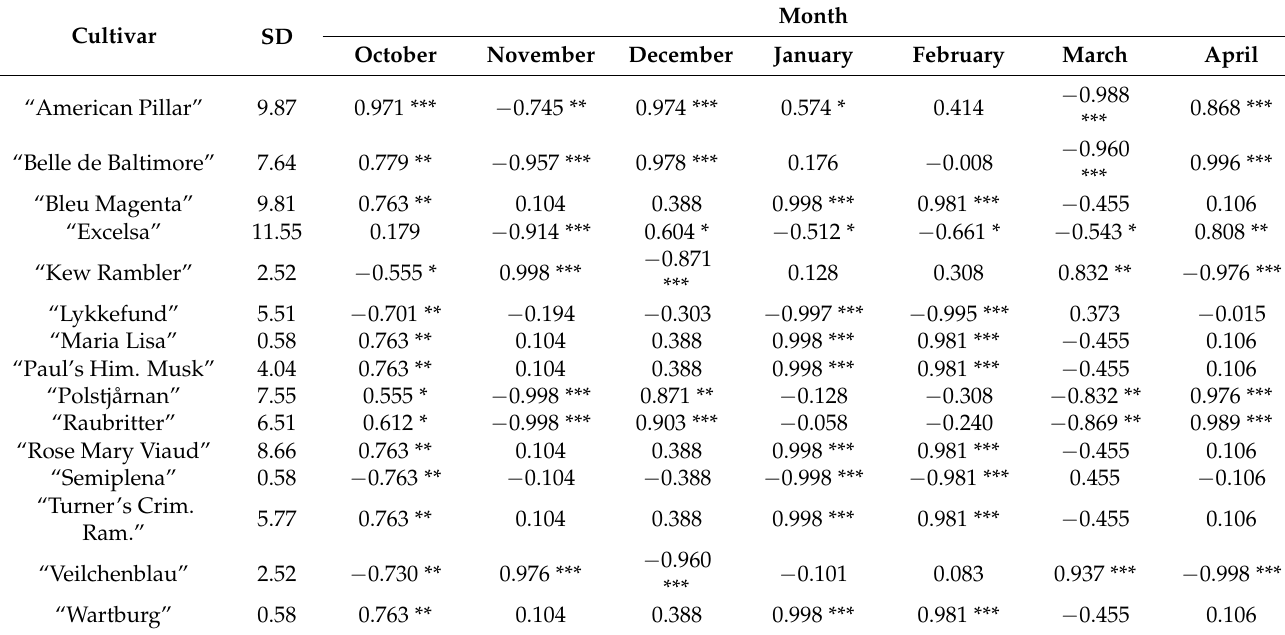
Table 6. The part of matrices of effect correlations between average monthly air temperature (2006, 2010, and 2016) and the start of the flowering period (BBCH 60 601) in rambler roses.